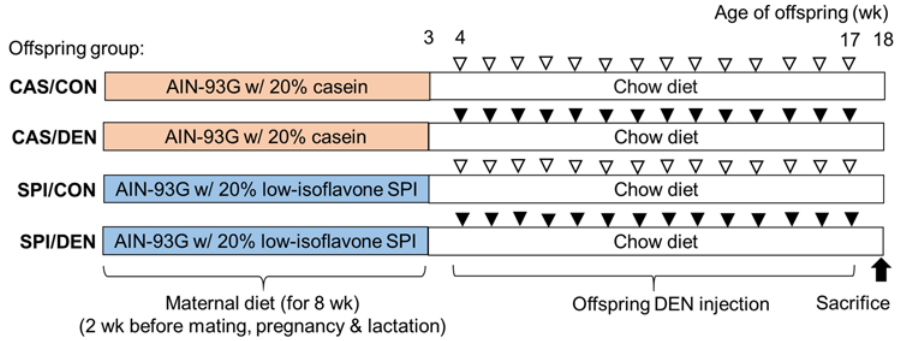
Figure 1. Experimental design. Dams were fed a casein diet (CAS) or a low-isoflavone soy protein diet (SPI) for two weeks before mating and throughout pregnancy and lactation. At three weeks of age, male o ff spring were separated from dams and acclimated to the regular chow diet. Four-week-old o ff spring from each set of dams received intraperitoneal injections of saline ( (cid:53) ) or diethylnitrosamine (DEN) at 50 mg / kg ( (cid:72) ) once a week for 14 weeks. At 18 weeks of age, male o ff spring were